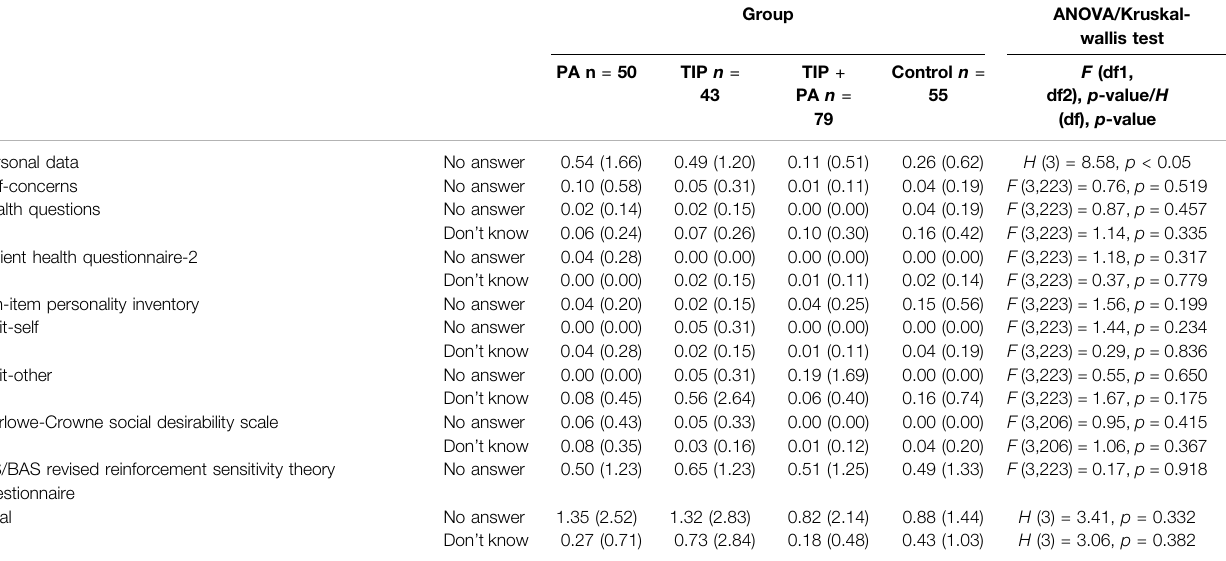
TABLE 4 | Means and standard deviations of number of “ no answer ” and “ don ’ t know ” in dependence of experimental group as well as corresponding analysis of variance (ANOVA) or Kruskal-Wallis test.